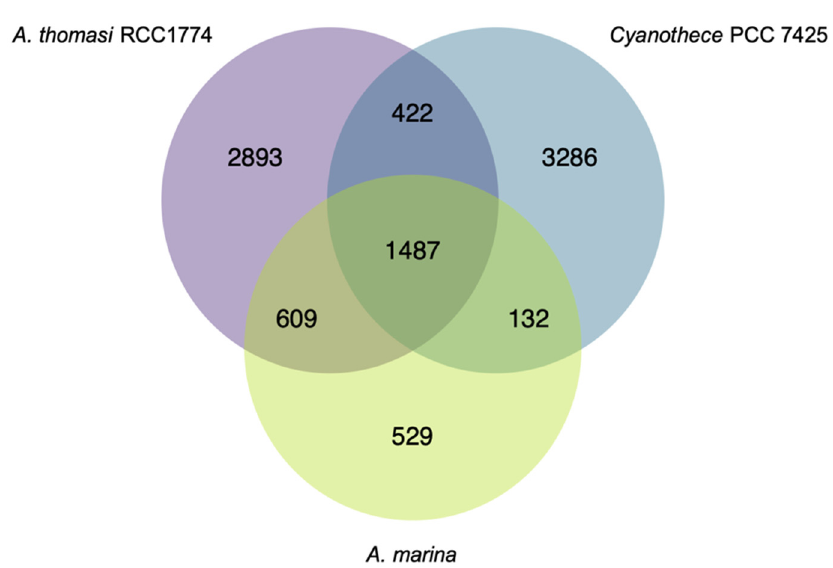
Figure 2. Venn diagram of shared and idiosyncratic protein-coding gene content among the A. marina core genome, the Acaryochloris thomasi RCC1774 genome, and Cyanothece PCC 7425 genomes. The diagram was generated with the R package VennDiagram.